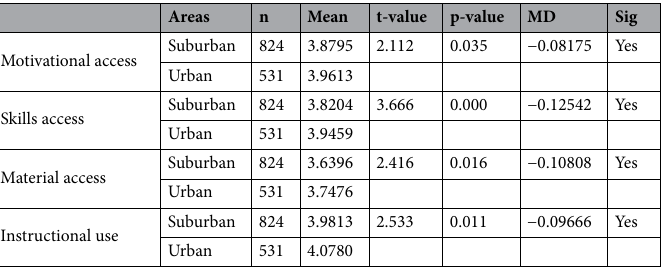
Table 6. Significant differences of all variables regarding geographical areas, suburban and